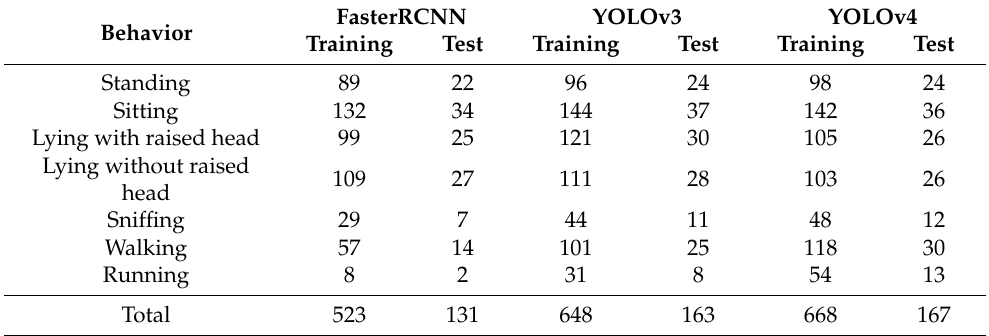
Table 4. Experimental dataset.